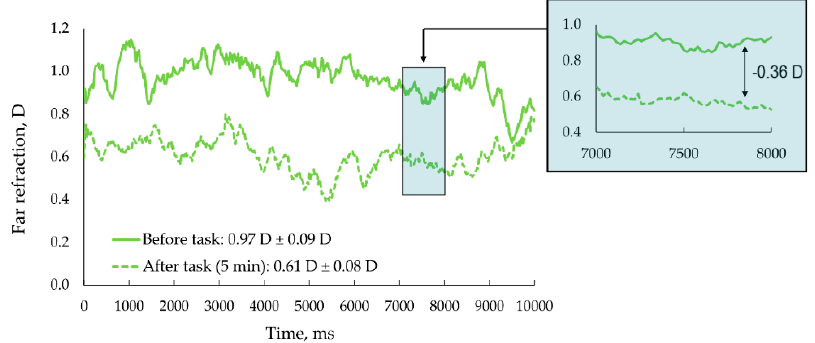
Figure 2. An example (22-year-old participant, Anaglyph 3D group) of actual recordings of baseline far refraction and post-task refraction. The green solid line corresponds to the refraction status and microfluctuations at baseline status, measured before the task. The green dashed line represents refraction status and microfluctuations, measured 5 min after completion of all tasks (duration 30 min). Changes in refraction shift after 30 min anaglyph 3D near work can be observed along with microfluctuations during steady fixation.